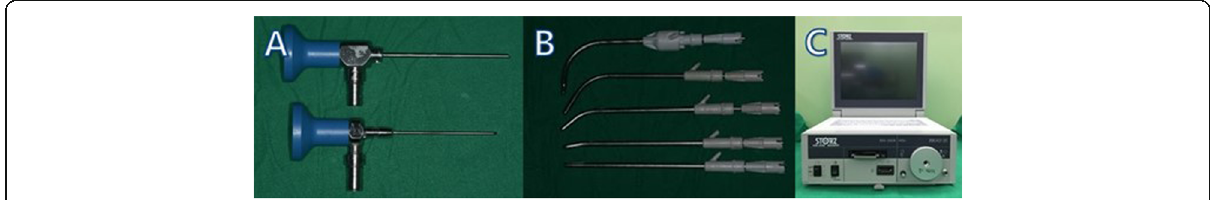
Fig. 1 Endoscopic visualization techniques in oral surgery. A Support endoscopy. Top: a Stryker endoscope (2.7 mm diameter, 30°). Bottom: a Stryker endoscope (1.9 mm diameter, 0°). B Straight and curved sinus blades (4 mm diameter, 90°; 4 mm diameter, 60°; 4 mm diameter, 40°; 4 mm diameter, 12°; 4 mm diameter, 0°; Medtronic). C The endoscope mobile unit with endoscope, monitor, light source, and archive system (Karl